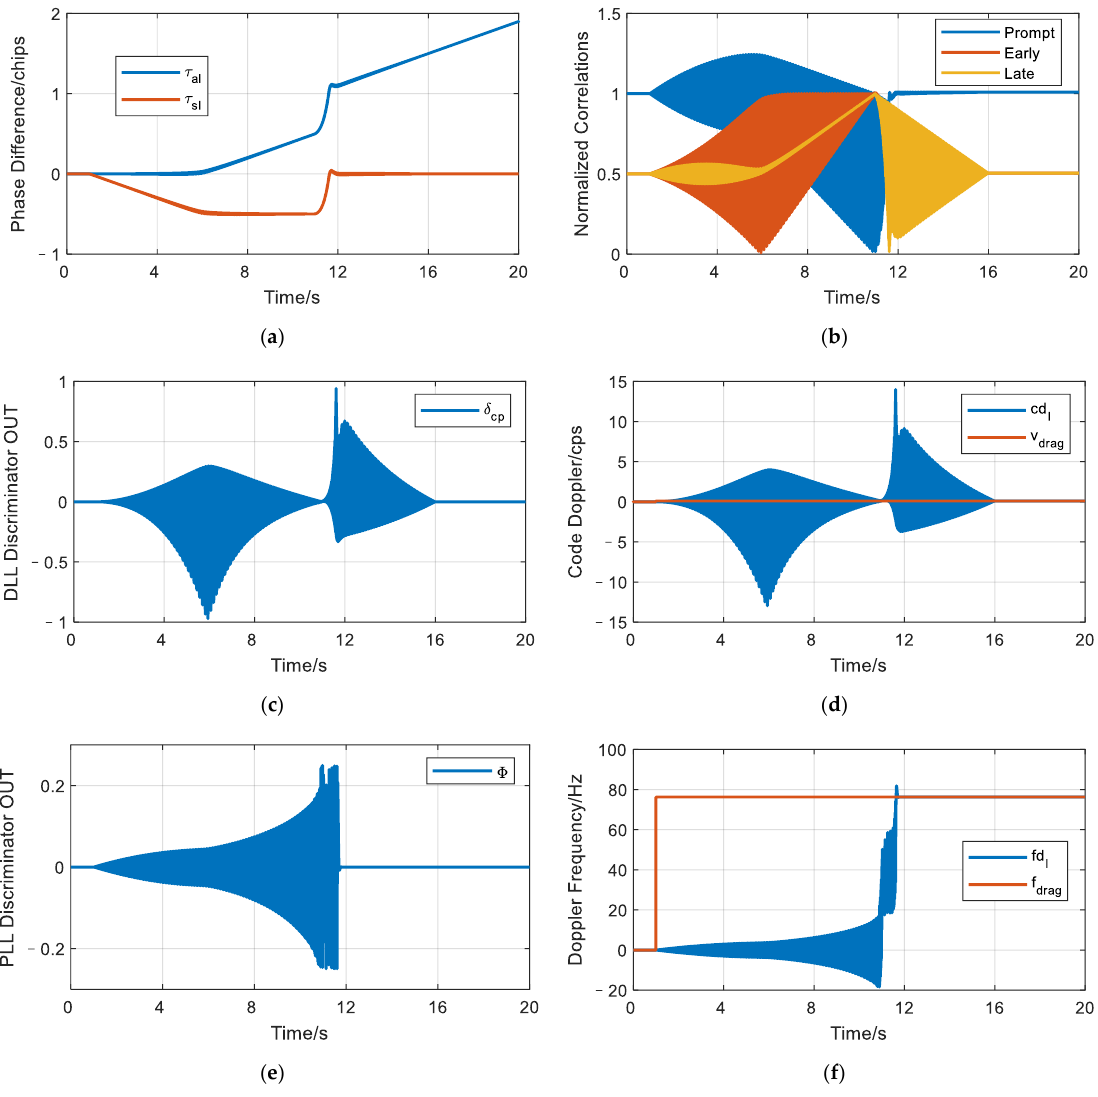
Figure 12. Theoretical simulation results of strategy 2. ( a ) Code phase differences; ( b ) Outputs of correlators; ( c ) Output of phase discriminator of the code loop; ( d ) Output of filter of the code loop; ( e ) Output of phase discriminator of the carrier loop; ( f ) Output of filter of the carrier loop.